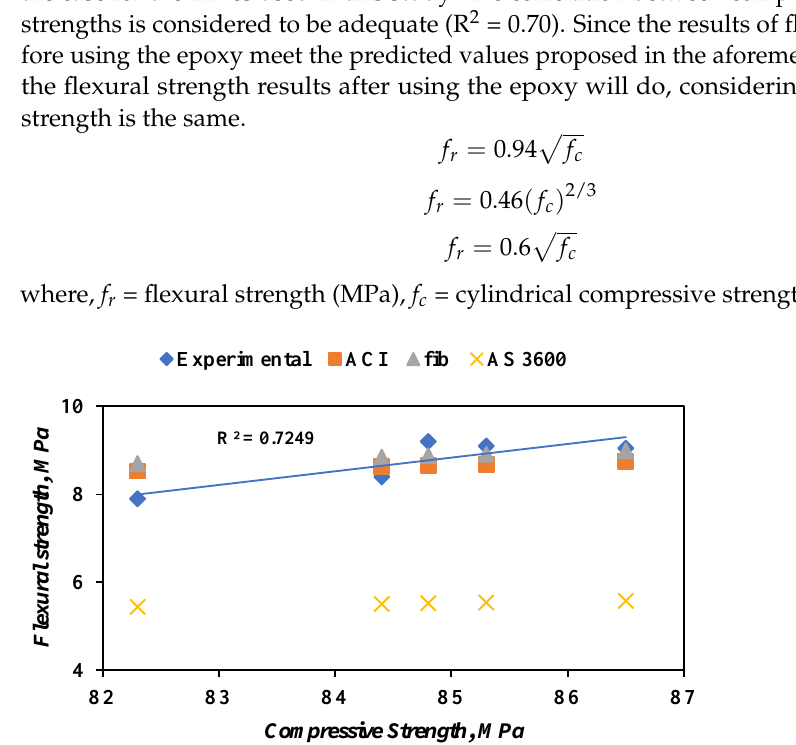
Figure 13. Relationship between flexural strength and compressive strength of FRSCC.